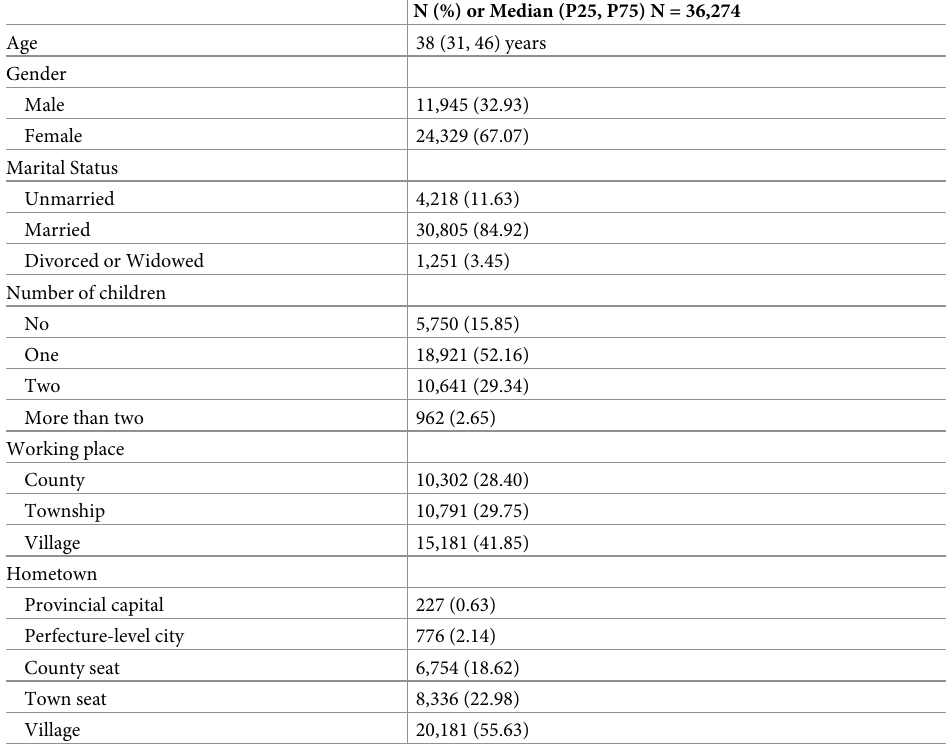
Table 3. General demographic